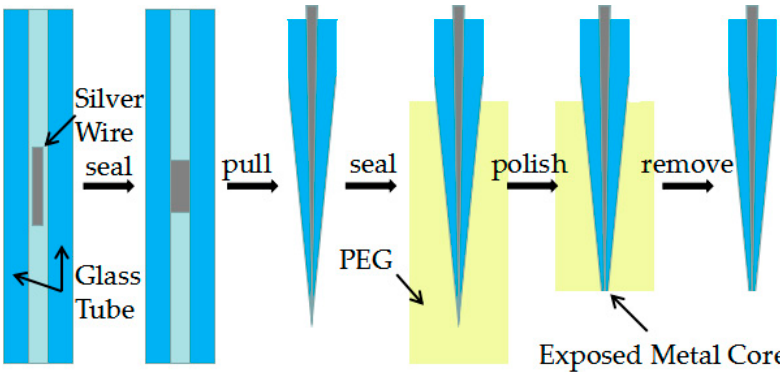
Figure 1. Process diagram showing the preparation of needle electrodes with the laser-assisted pulling method.